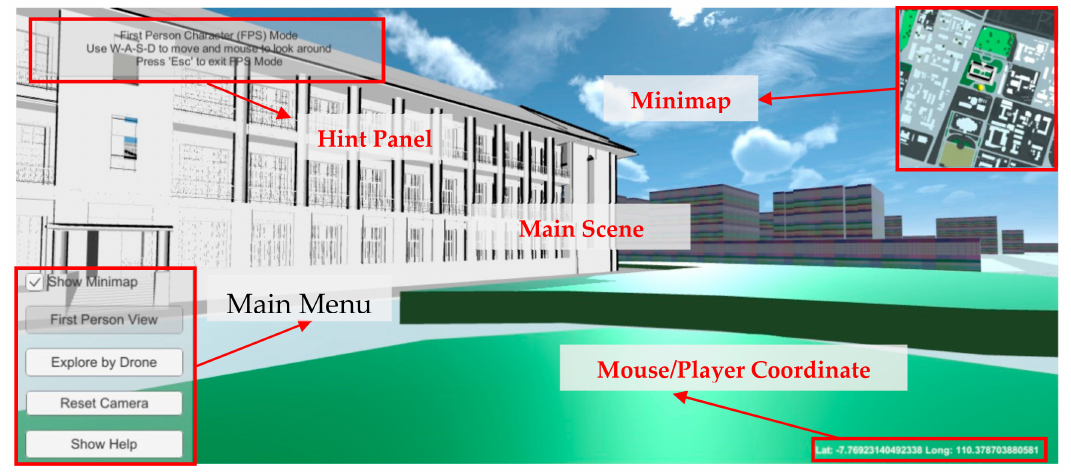
Figure 9. Main interface of the 3D geovisualization